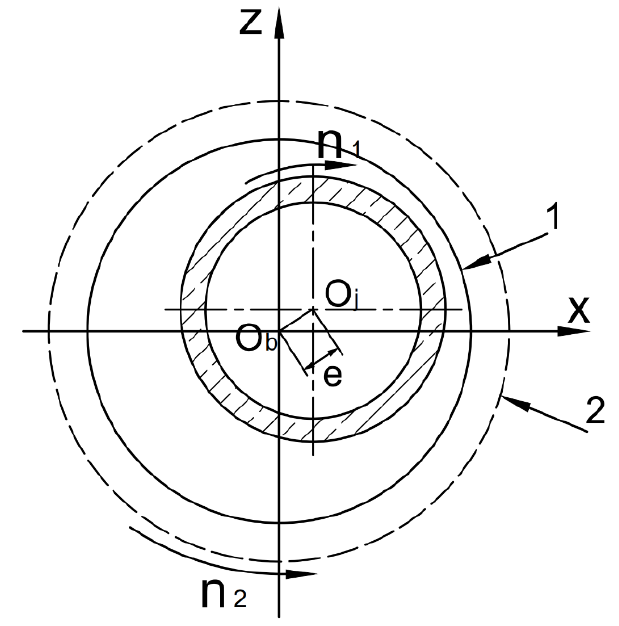
Figure 12. Schematic diagram of the sealing ring’s centrifugal expansion.